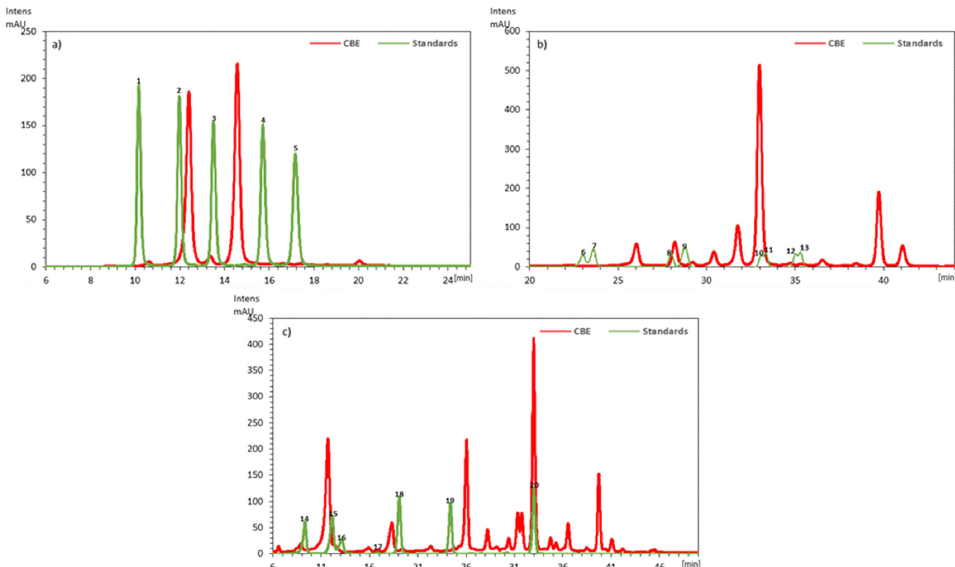
Figure 1. Expanded DAD-chromatograms of CBE and standards for ( a ) anthocyanins (detection at 520 nm), ( b ) flavonols (detection at 360 nm), and ( c ) phenolic acids and stilbenes (detection at 320 nm). (1) Delphinidin-3-glucoside; (2) cyanidin- 3-glucoside; (3) petunidin-3-glucoside; (4) peonidin-3-glucoside; (5) malvidin-3-glucoside; (6) myricetin-3-glucoside; (7) myricetin-3-glalactoside; (8) quercetin-3-glucoside; (9) quercetin-3-glucuronide; (10) kaempherol-3-glucoside; (11) kaempherol-3-rutinoside; (12) isorhamnetin-3-glucoside; (13) isorhamnetin-3-rutinoside; (14) t -coumaric acid; (15) caffeic acid; (16) syringic acid; (17) fertaric acid; (18) p -coumaric acid; (19) ferulic acid; and (20) t -resveratrol.